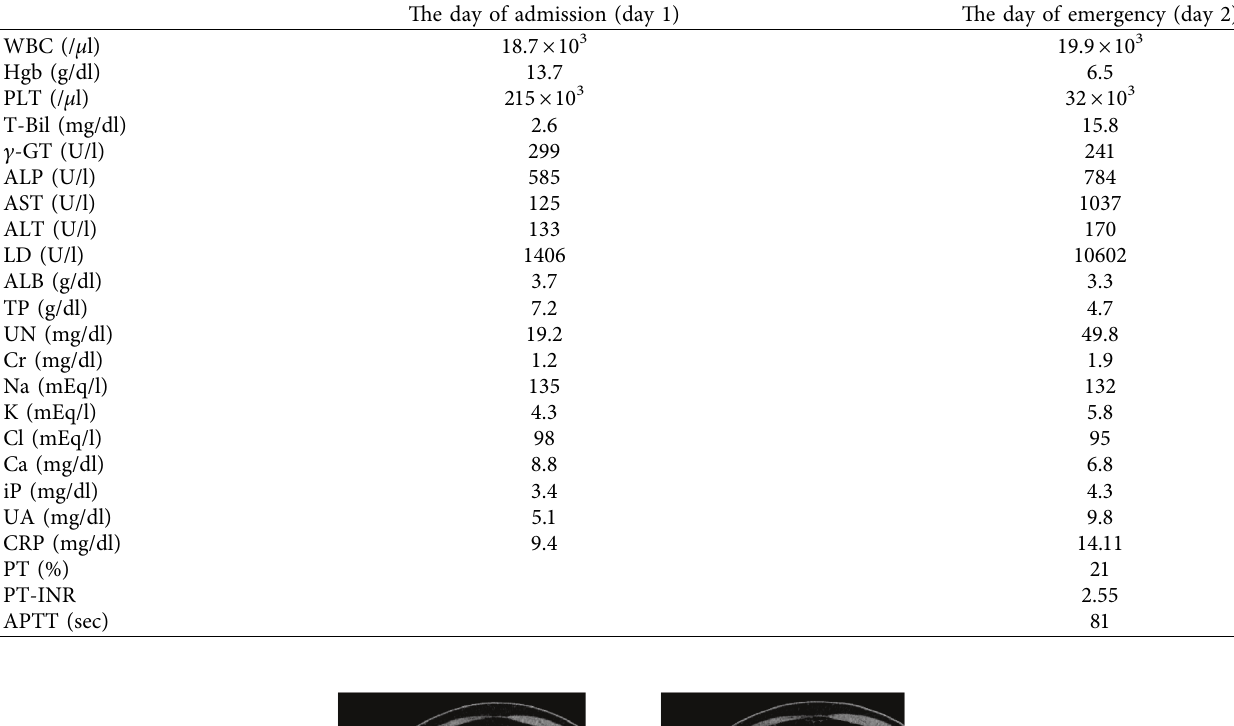
Table 1: Laboratory